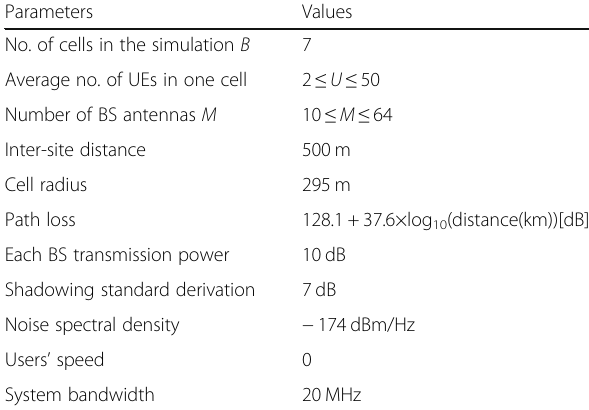
Table 1 Simulation parameters setting